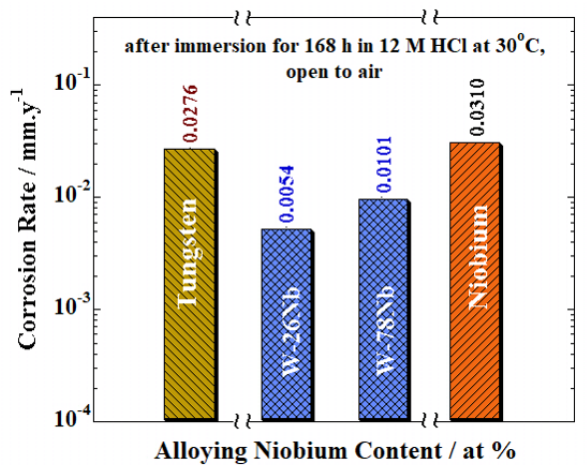
Figure 2: Estimated corrosion rates of W, Nb and W-xNb (x = 26 and 78)